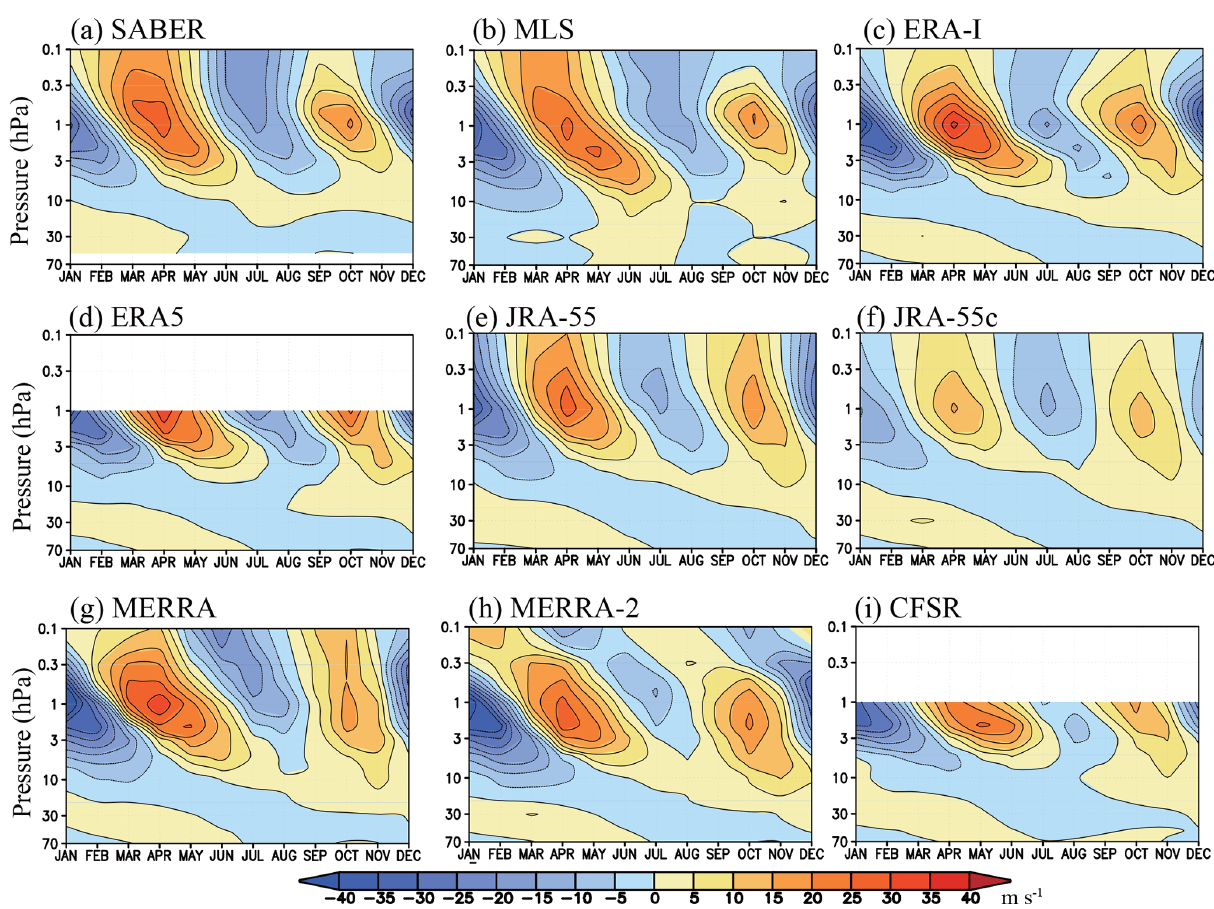
Figure 10. The same as Fig. 9 but with annual mean climatological zonal winds (shown in Fig. 2a) removed at each